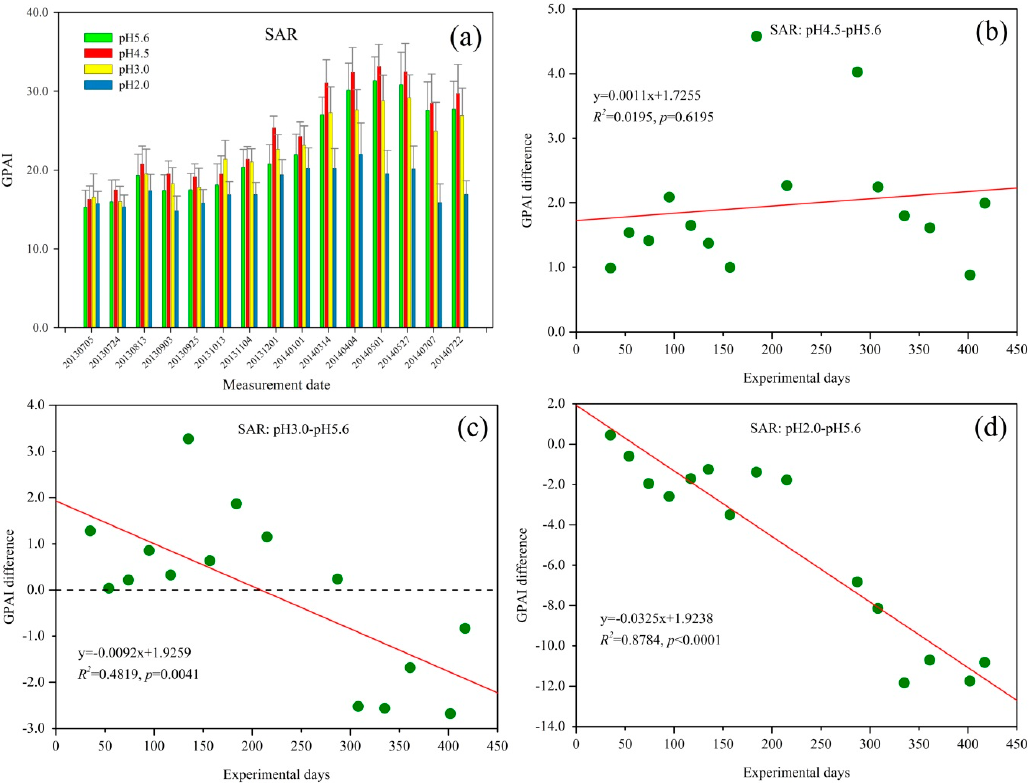
Figure 3. ( a ) Green peak area index (GPAI) trend of Q. glauca under sulfuric acid rain (SAR) treatment; and ( b – d ) the GPAI difference between different stress levels of SAR.